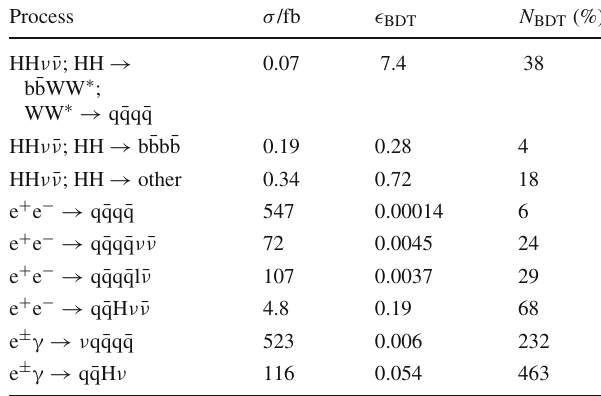
Table 2 Cross sections, σ , selection efficiencies, (cid:14) BDT , and expected number of events in the HH → b ¯ bWW ∗ signal region, N BDT , at 3TeV for L = 5ab − 1 . The cross sections are for unpolarised beams; the number of events assumes the 4:1 polarisation scheme [16]